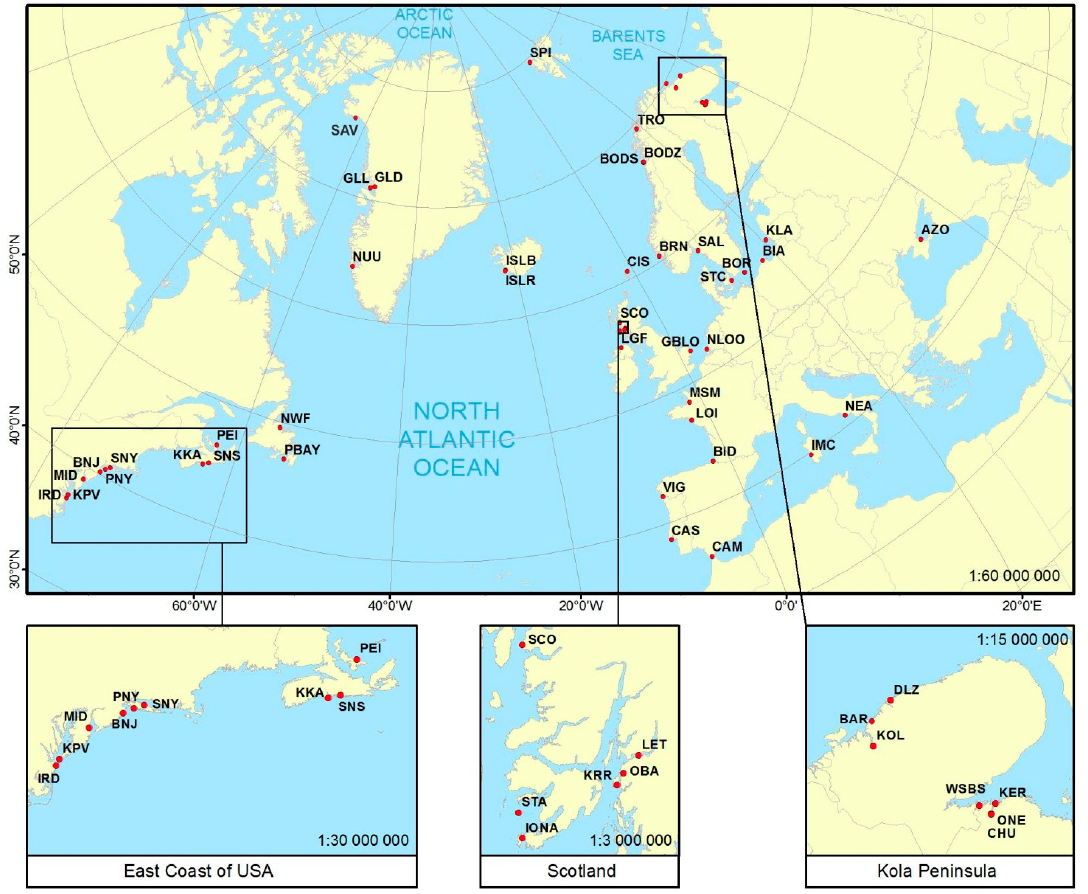
Figure 1. Geographic location of 53 Mytilus spp. sampling sites. See Table 1 for definition of site abbreviations.